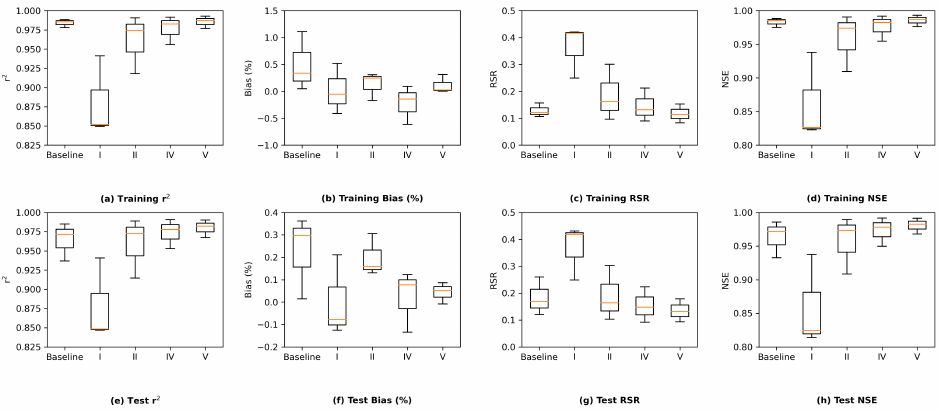
Figure A9. Box and whisker plots of four types of metrics consisting of r 2 , percent bias, RSR, and NSE on stations belonging to the northern Delta group during the training (panels ( a – d )) and test (panels ( e – h )) phases of the grouped (G) LSTM model under five scenarios: baseline and four different memory lengths as presented in Table 1.